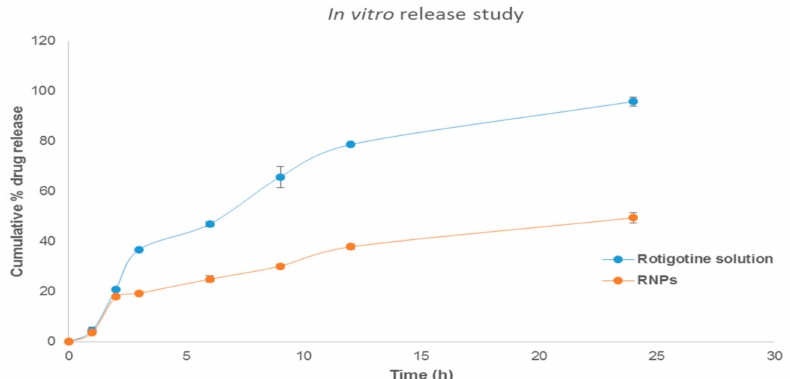
Figure 11. In vitro release studies of rotigotine solution and rotigotine-loaded chitosan nanoparticles (RNPs) in PBS at pH 7.4 ( n =